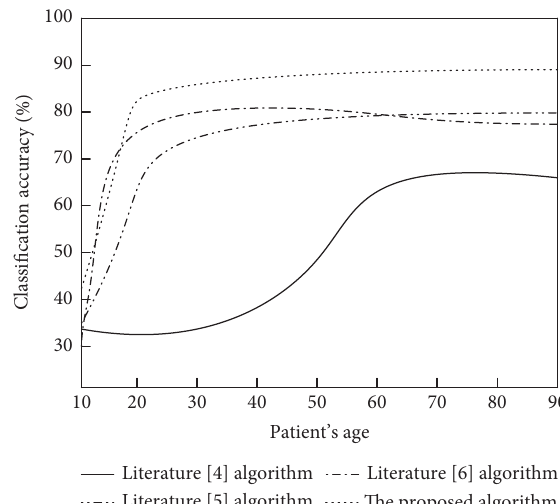
Figure 5: Comparison results of the clinical feature classification